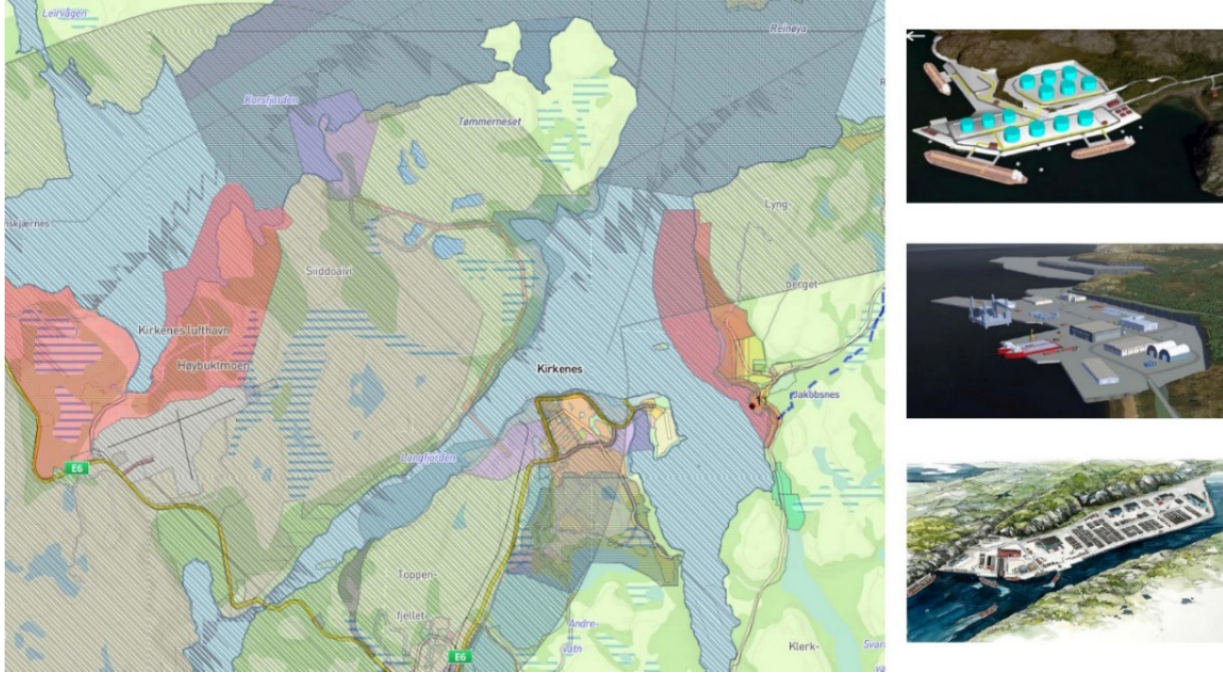
Figure 1. Extract of municipal map of Kirkenes showing the two last remaining options for the potential new port develop‐ ment at Leirpollen or Slambukta. Sources: Statens Vegvesen (2015) and Norconsult